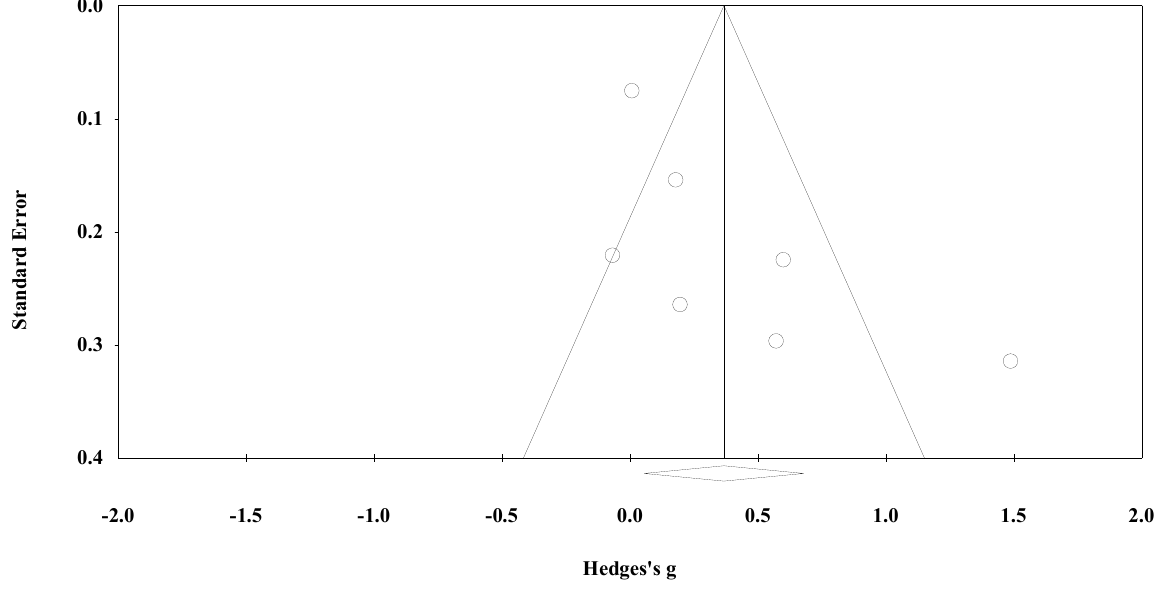
Note. k = 7; The diamond represents the average effect size (Hedges’s g ).